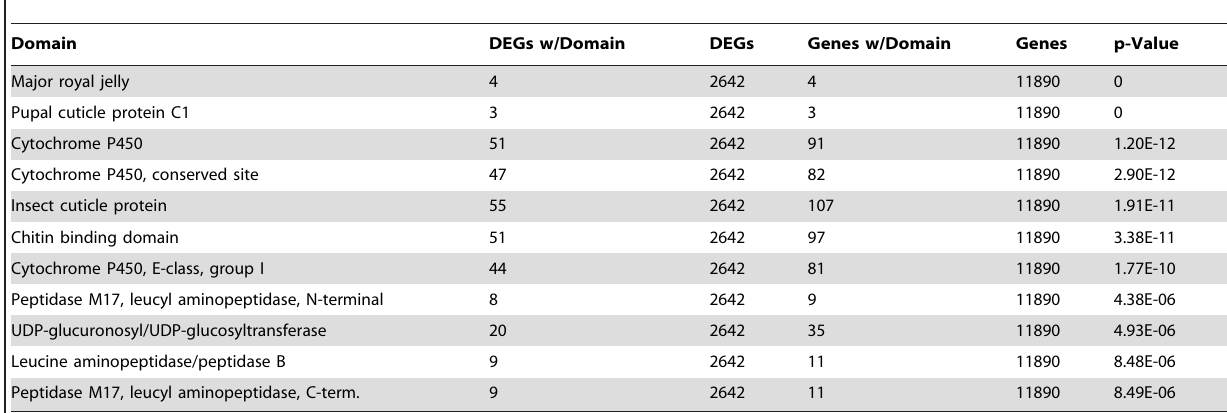
Table 4. Domain enrichment analysis for Ama-KTT/M/2 on a -amanitin versus Ama-KTT/M2 on no toxin (group 3 versus 2).